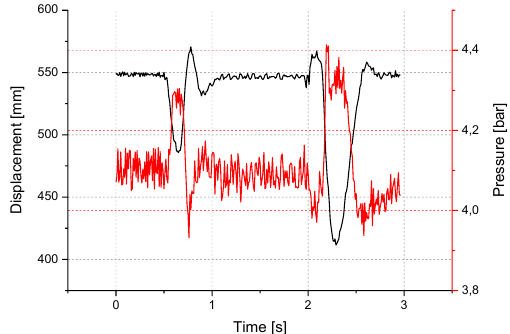
Fig.7. Vibro-isolating mass displacements with pressure change